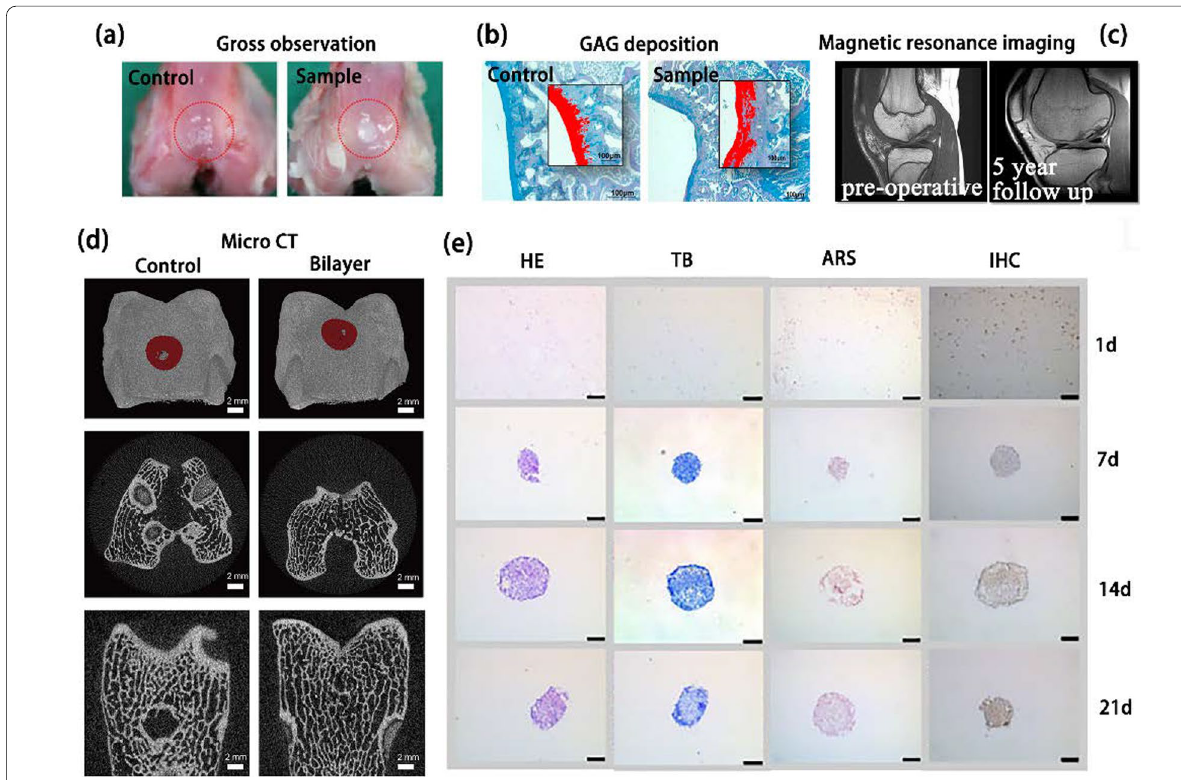
Fig. 5 General characterization for cartilage repairs with respect to direct observing and bio-indicators recognizing. a Gross observation and records of defect repairing. ( Adapted from ref. [135], copyright 2021, with permission from the Springer Nature.) b Histochemical evaluation of deposition of GAG by Alcian Blue staining. (Adapted from ref. [93], copyright 2020, with permission from MDPI.) c Magnetic resonance imaging of comparison of an osteochondral graft at ten-year follow-up investigation. The alterations of subchondral bone and graft filling reflected the repairing performance by graft. (Adapted from ref. [23], copyright 2021, with permission from Springer Open.) d Representative Micro-computed tomography (Micro-CT) images defect site and surrounding area. Bilayer represents the scaffold fabricated by human-like-collagen, hyaluronan and nano-hydroxyapatite particles. (Adapted from ref. [59], copyright 2020, with permission from Science China Press and Springer Nature) e Major staining methods for bio-indicator evaluations. HE used Hematoxylin–eosin staining (HE) describes the general morphology of cell and regenerated tissue. Toluidine blue (TB) identifies the hyaline cartilage by staining sulfate glycosaminoglycans. Alizarin red staining (ARS) assesses the calcium deposition. Immunohistochemical staining supplies the synthesis and secretion of collagen type I and II. (Adapted from ref. [103], copyright 2020, with permission from